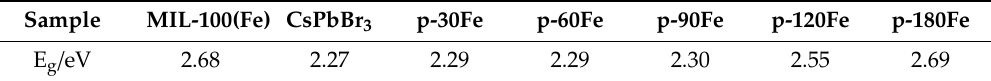
Table 2. Bandgap data of the prepared samples.